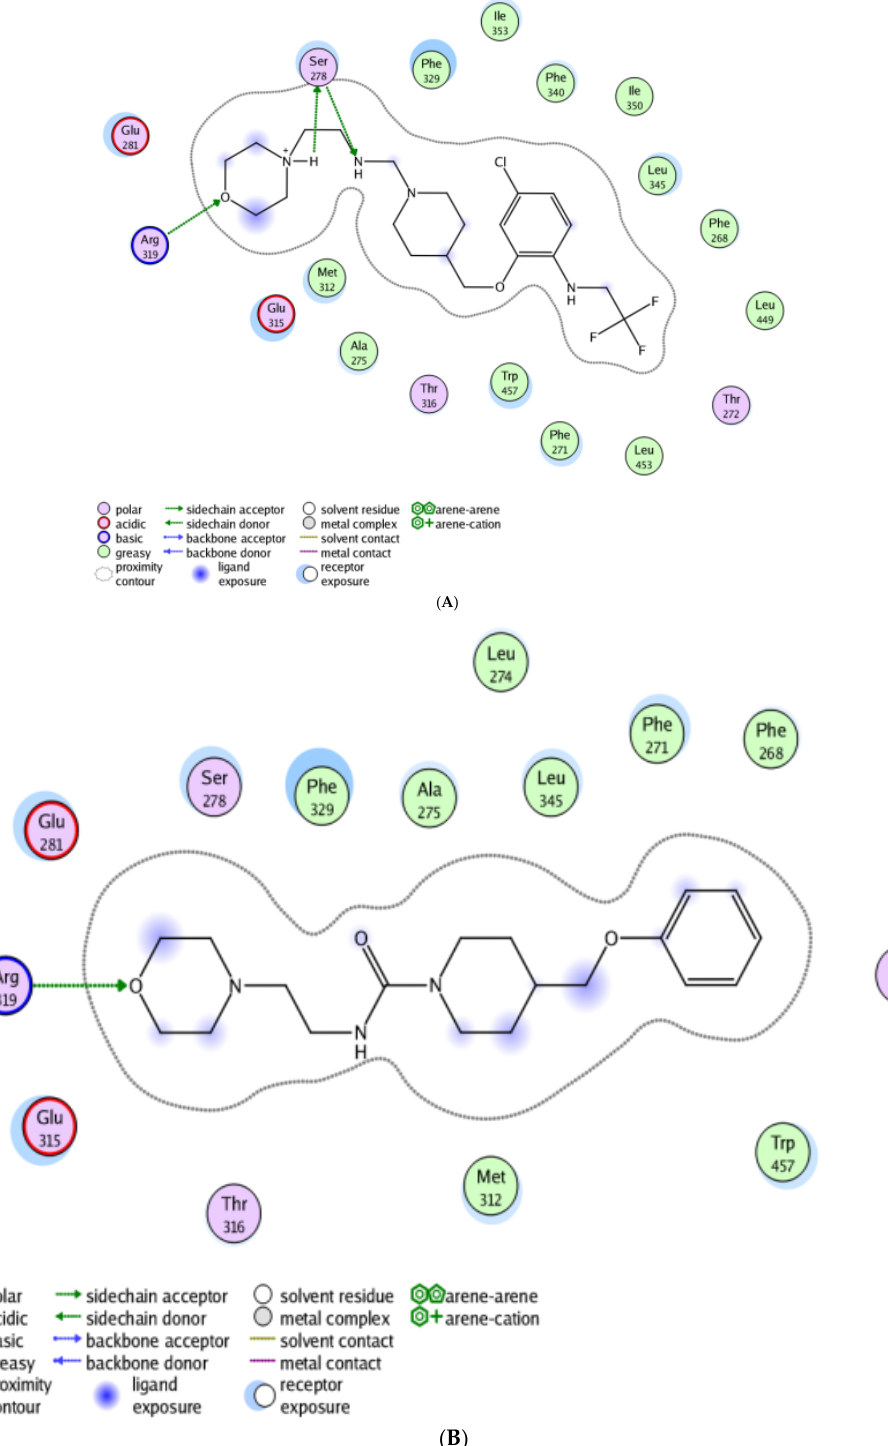
Figure 3. The binding modes of new designed compound N1 ( A ) and the template compound (ZINC55084484) ( B ) in the LXRβ active site. Table 7. Drug-like property descriptors of new designed LXRβ-selective agonists .